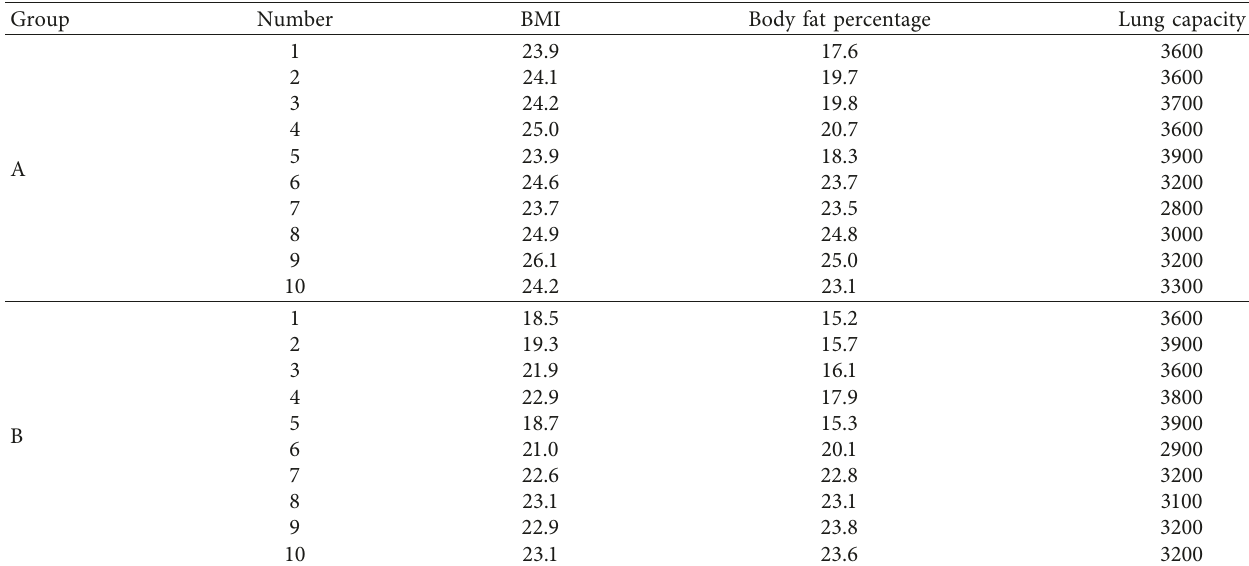
Table 5: Numerical table of test indicators after subject